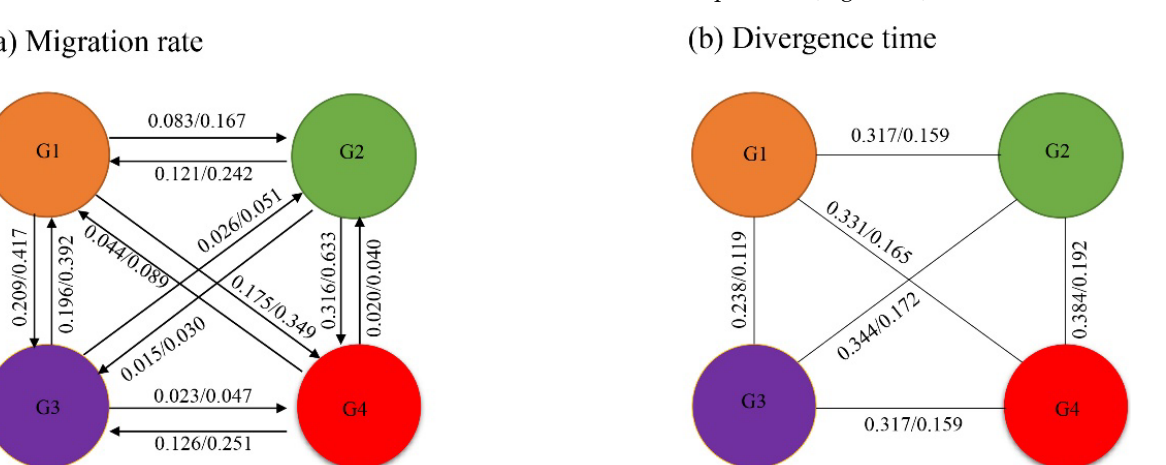
G4, as well as between G3 and G4, showed similar patterns (Figure 4a).